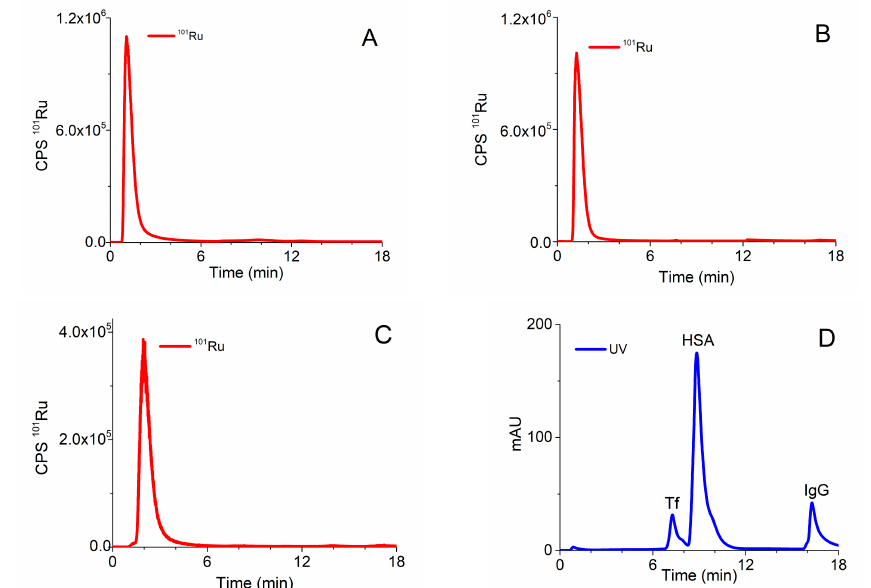
Figure 2. Typical chromatograms of separation of ( A ) Ru3+ (2 µg/mL Ru), ( B ) complex ( 1 ) (1.64 µg/mL Ru), ( C ) complex ( 2 ) (1.60 µg/mL Ru) followed by ICP-MS detection at m / z 101, and ( D ) 5-times diluted mixture of standard serum proteins (25 g/L HSA, 5 g/L IgG and 2.5 g/L Tf) monitored by UV spectrometry at 278 nm.